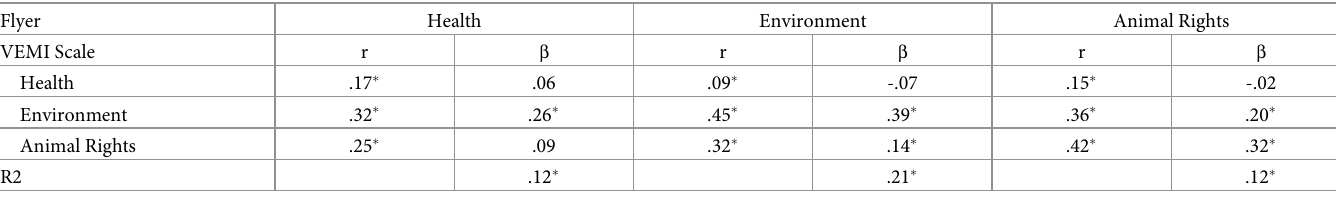
Table 8. Correlations and regression coefficients indicating associations between VEMI scale scores and attitudes about advocacy